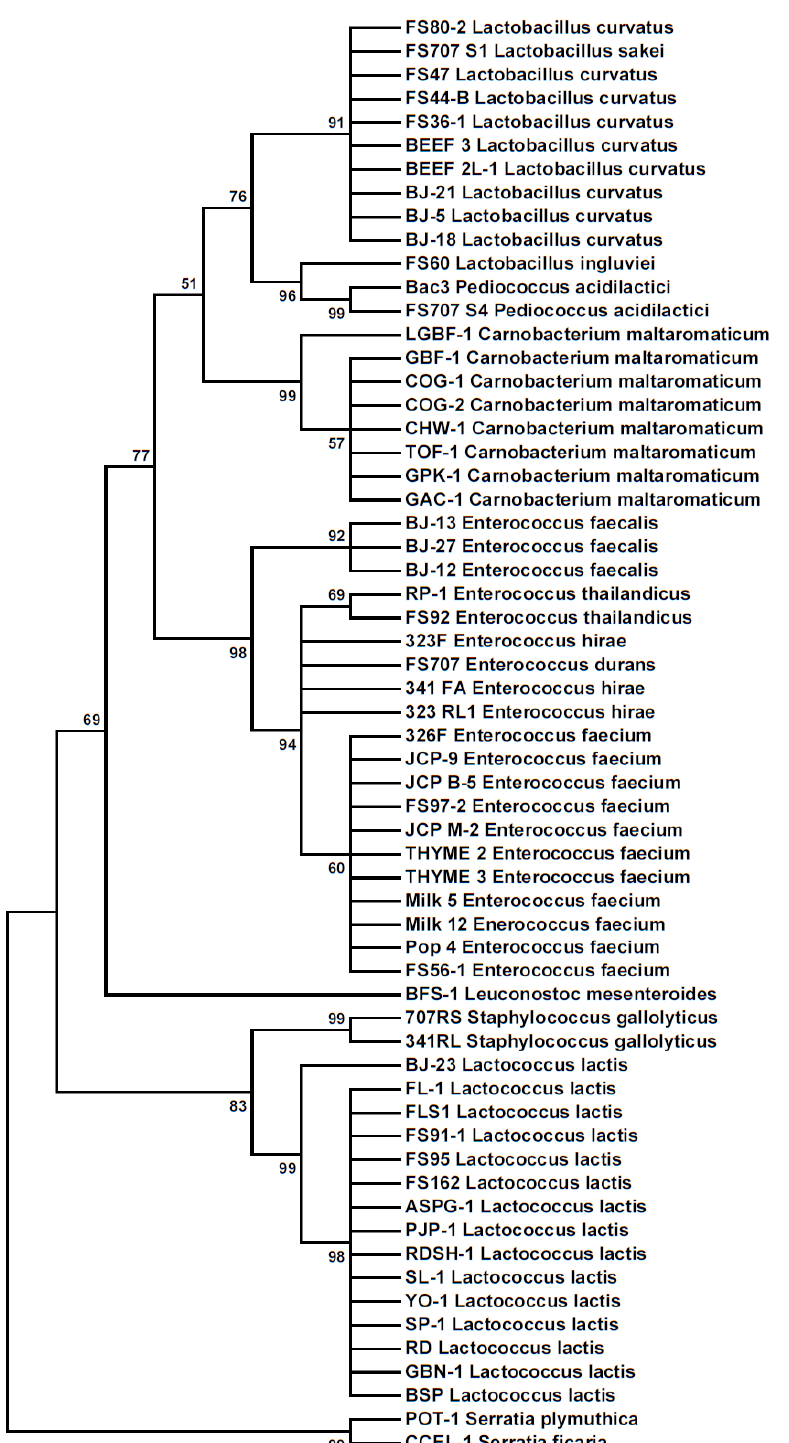
Figure 3. Phylogenetic tree of 16S rRNA partial sequences from Bac + bacteria by the Maximum Likelihood method. The phylogenetic relationship was inferred using the Tamura-Nei model [21] showing the tree with the highest log likelihood (−2162.4232). The percentage of trees in which the associated taxa clustered together is shown next to the